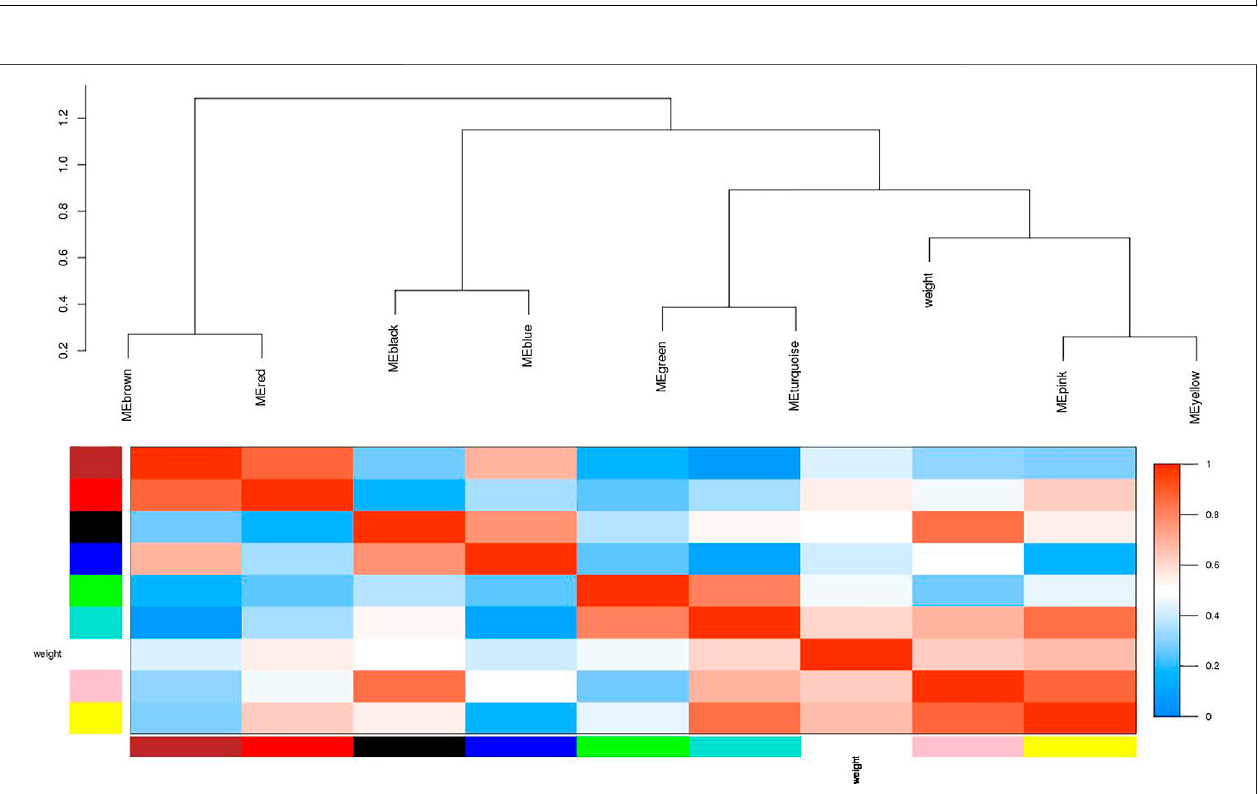
FIGURE4| Visualization oftheeigengenes networkrepresentingtherelationships among themodules. Thetop panel showsahierarchicalclusteringdendrogram of the modules based on the dissimilarity score of E i and E j given by 1 − cor (E i , E j ). The heatmap in the bottom panel shows the eigengenes adjacency A ij (cid:1) (1 + cor (E i , E j ))/2.